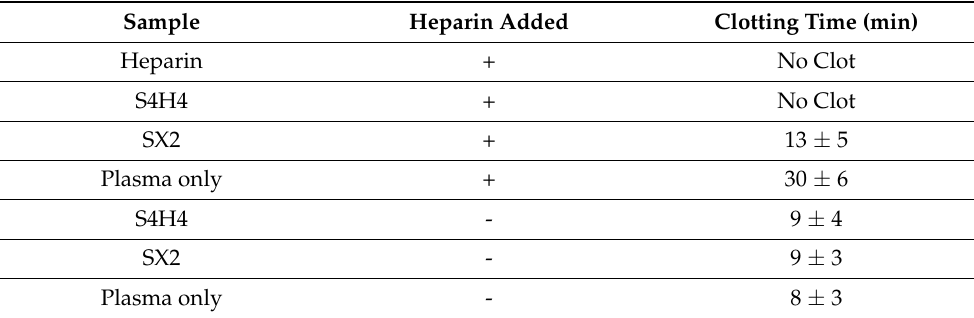
Table 2. A comparison of average times needed for visual clot formation either in the presence or absence of heparin.